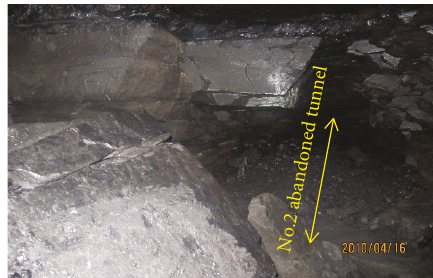
Figure 12: No.2 abandoned